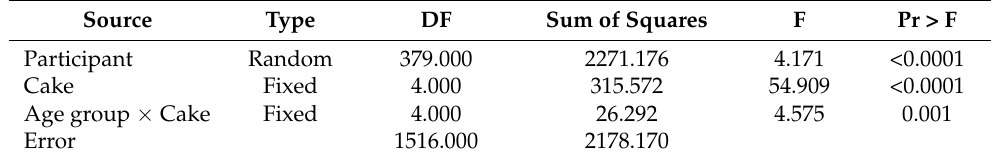
Table 1. ANOVA mixed models to test significant differences between fixed and random